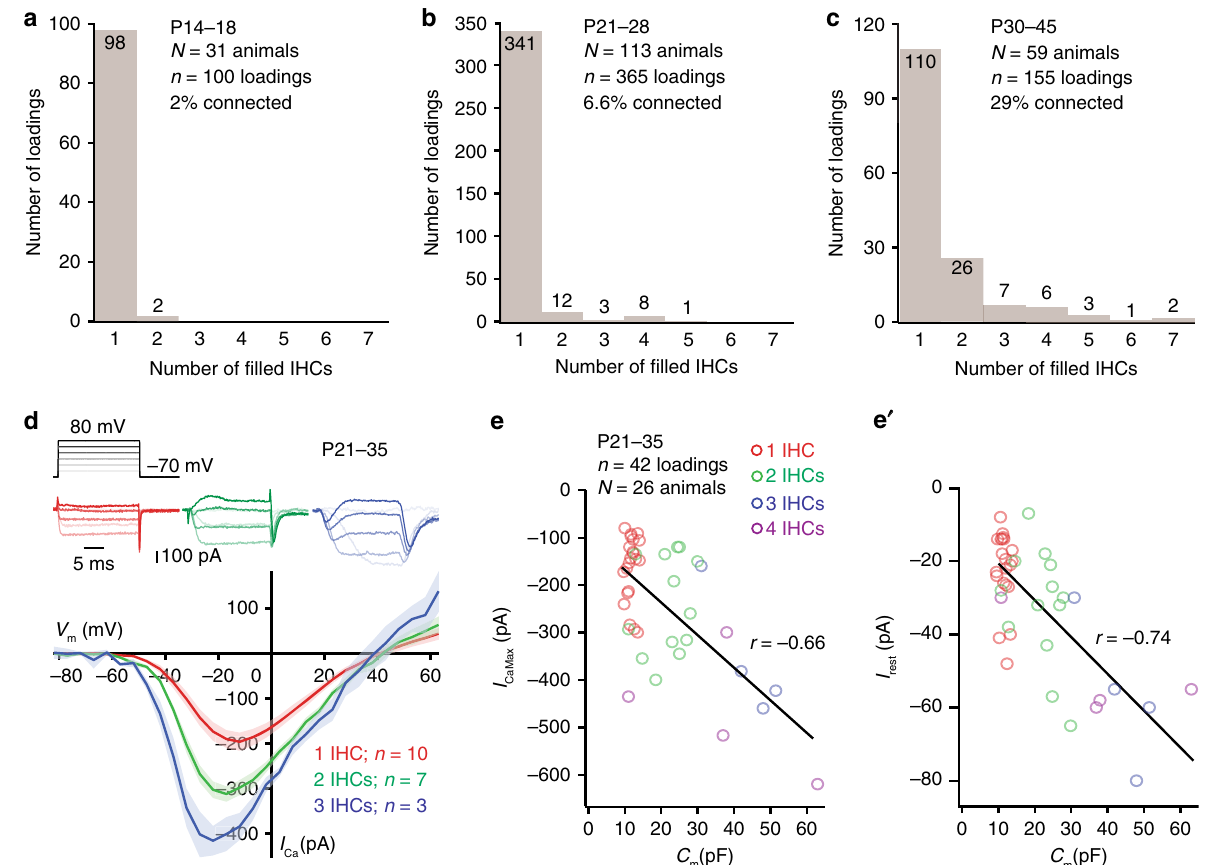
Fig. 2 IHC coupling is age-dependent and electrical. a – c Histograms displaying the number of dye- fi lled IHCs per loading at 3 different developmental stages. d Representative whole-cell Ca 2 + -currents ([Ca 2 + ] e = 5 mM) of a single IHC (red), 2 (green), and 3 (blue) coupled IHCs evoked by step depolarizations from − 70 to 80 mV at P21 – 35 (as in e , f ). Current-voltage relationships (IVs) in single and dye-coupled IHCs with mean (line) ± S.E.M. (shaded areas). Scatter plots and line fi ts relating I CaMax ( e ) and I rest ( e ′ ) currents against C m values according to the number of dye-coupled IHCs. C fi ndings exclude GJs and P2X7-dependent macropores as mechanisms underlying IHC coupling.